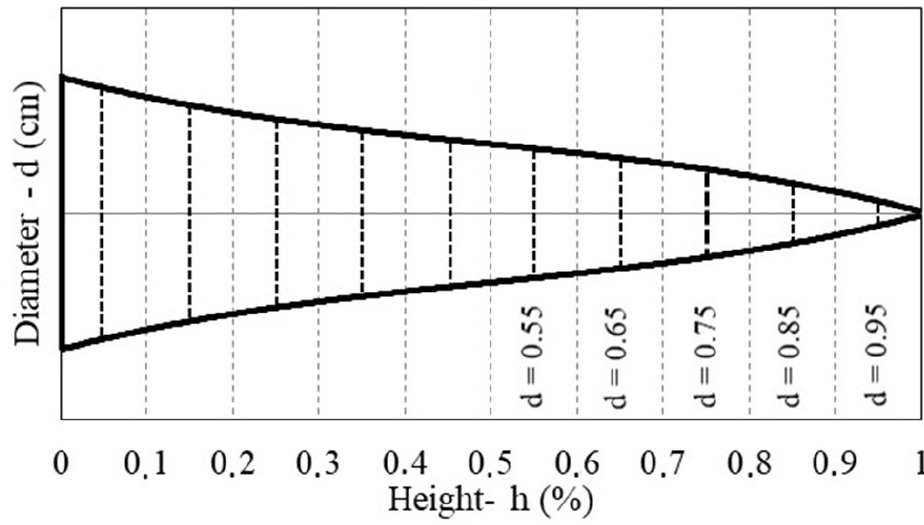
Figure 1 - Schematic drawing used for measurement of the diameters by Hohenadl’s